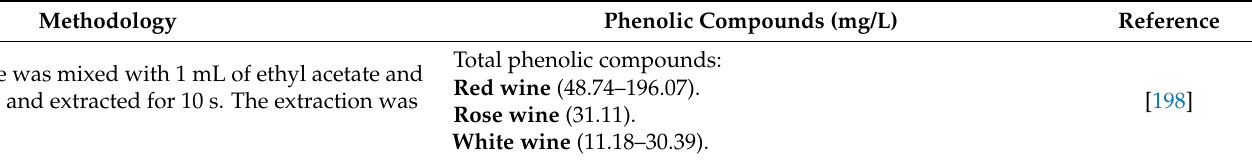
Table 5. Phenolic compounds concentration from Vitis Vinifera varieties according to different extraction methodologies. n.d: not